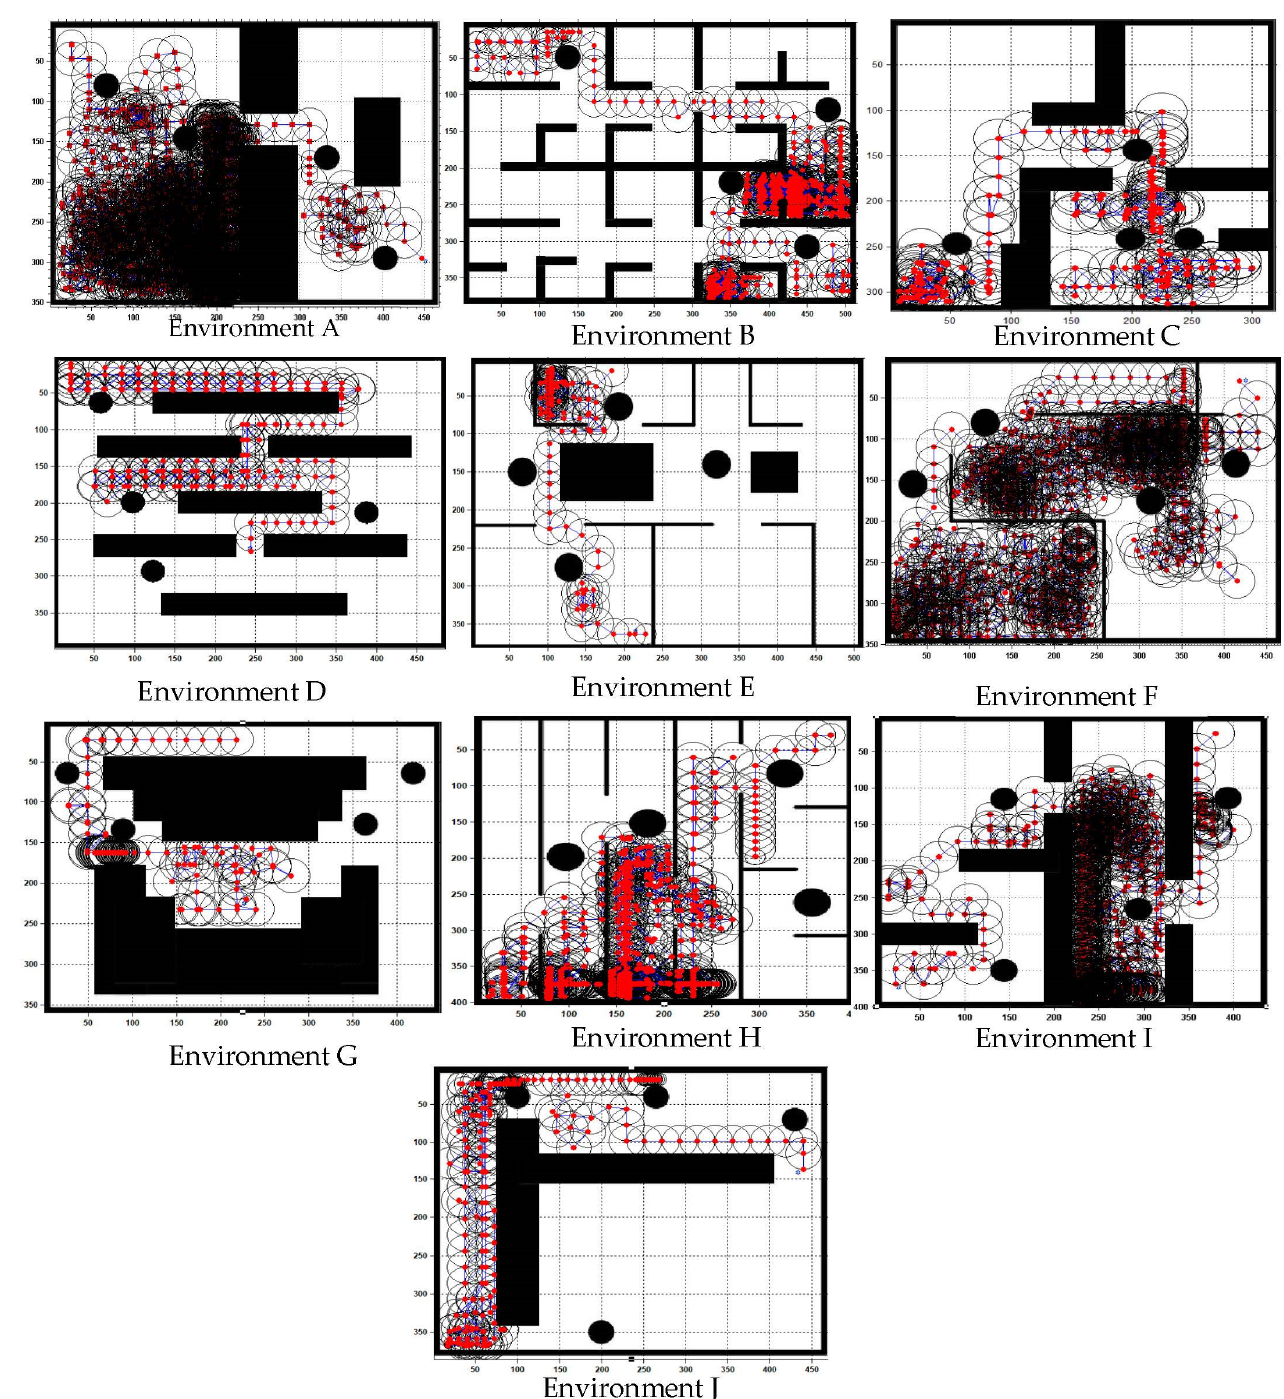
Figure 8. Results of obstacle avoidance GLS—first stage (wave generation).